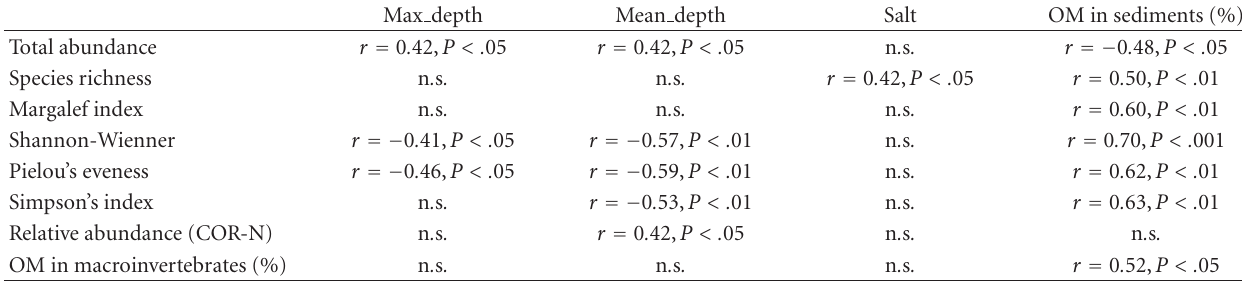
Table 5: Significant Pearson correlation coe ffi cients r (Pearson r , P < . 05) between abiotic variables, and total abundance, diversity indices, relative abundance, and percentage of organic matter in macroinvertebrate